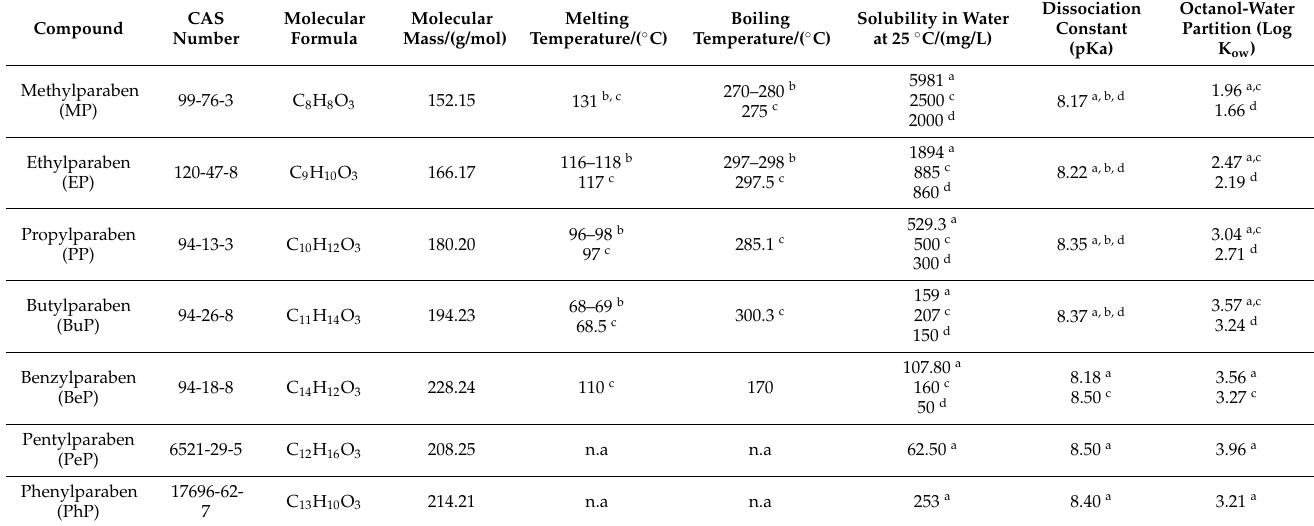
Table 1. Properties of